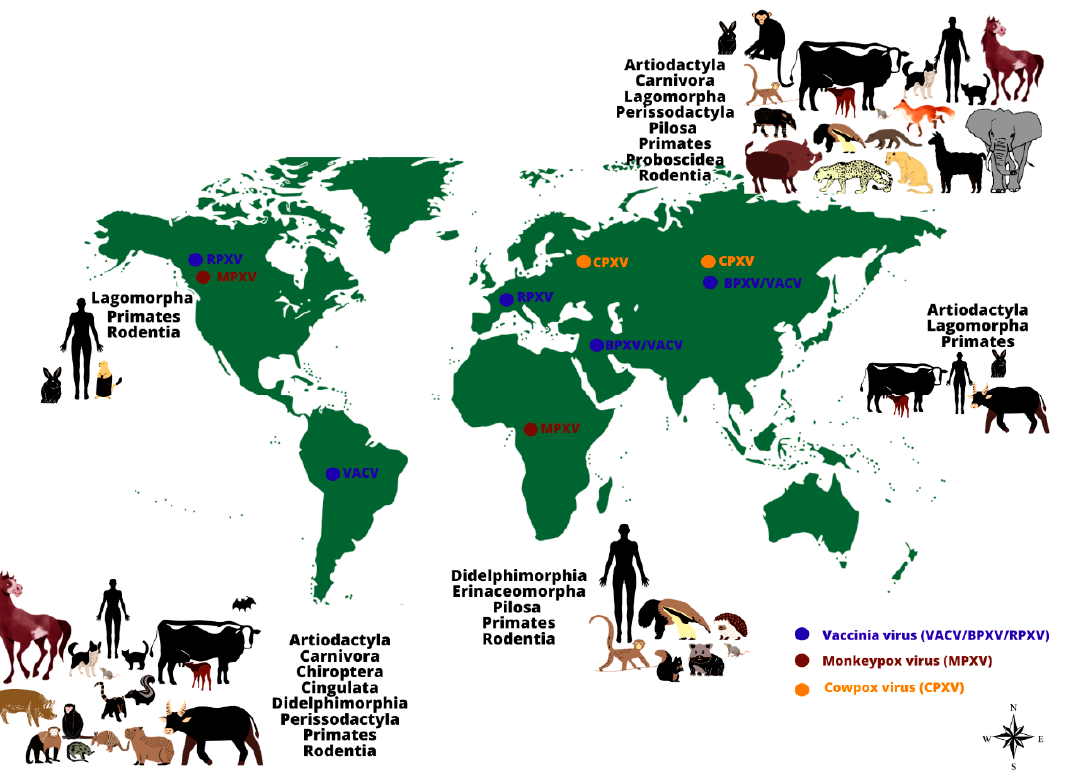
Figure 1. The worldwide distribution and host range of monkeypox, cowpox and vaccinia viruses. The image shows the range of animal hosts (represented by orders) that have been demonstrated to be naturally infected by some Orthopoxvirus species, according to different regions of the world (except by Monkeypox virus in the United States of America, represented by imported cases). Orthopoxvirus infections have been demonstrated in animals belonging to different orders, using different methods (virus isolation, molecular detection of viral genomes or serological screening for antibodies against orthopoxviruses). The occurrence of some zoonotic orthopoxviruses has already been confirmed (by virus isolation or molecular detection of the viral genome) in some geographical regions (indicated by colored dots: blue: vaccinia virus (including buffalopox and rabbitpox viruses) in South America, Europe, Asia, and the Middle East; brown: monkeypox virus in Africa and North America; orange: cowpox virus in Europe and Asia).